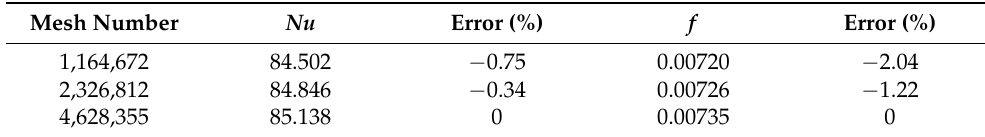
Figure 5. Mesh model of helical pipe. Table 3. Mesh-independence test for helical pipes.